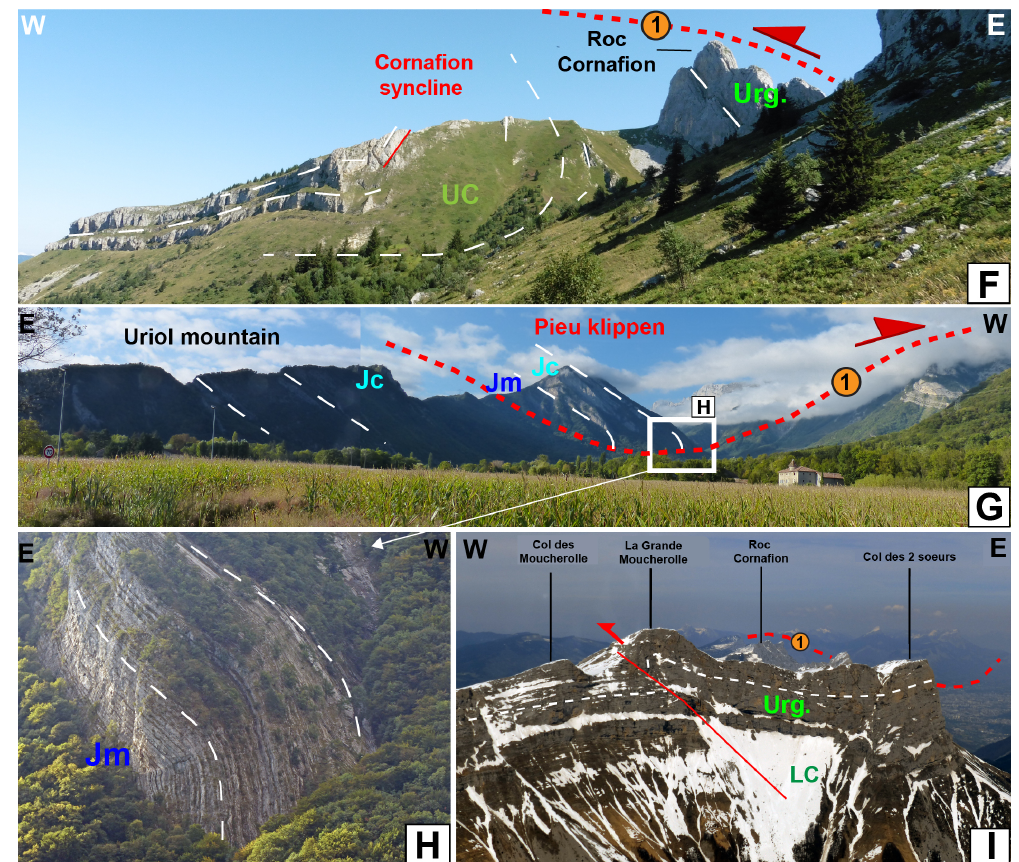
Figure 6. Field and aircraft pictures of the Chartreuse oriental and Moucherotte thrusts (FZ1) in southern Chartreuse and northern Vercors. See viewpoints A to I and locations in Fig. 7A. M: Miocene; UC: Upper Cretaceous; Urg.: Urgonian (Barremian–Aptian limestones); LC: Lower Cretaceous; Jc: Upper Jurassic limestones; Jm: Upper Jurassic marls. Dashed white lines underline the stratifications. Thrust faults are in red. Orange circle: fault zone (FZ). (A, B) Néron and Moucherotte thrusts, aerial views from the N. The Proveyzieux Miocene deposits are underthrusted below the Néron syncline. Beyond the Isère valley, the Sassenage fold capped with Miocene deposits is underthrusted below the Moucherotte massif. Note that the Proveyzieux syncline corresponds to two synclines separated by an anticline. (C) View towards the south of the Col de l’Arc and the Crête des Crocs: the folded Urgonian is thrusted above the Upper Cretaceous. (D) Urgonian limestones of the Moucherotte anticline in the FZ1 hanging wall. (E) View towards the west of the eastern flank of the Moucherotte massif with the FZ1 geometry. (F) View towards the north of the Cornafion syncline. The Urgonian is overturned in the FZ1 footwall. (G) Duplication of the Jurassic series in the Pieu klippe; view from the north. (H) Zoomed-in view of the anticline on the hanging wall of FZ1 in the Pieu klippe. (I) View towards the north of the Grande Moucherolle, where autochthonous series are weakly